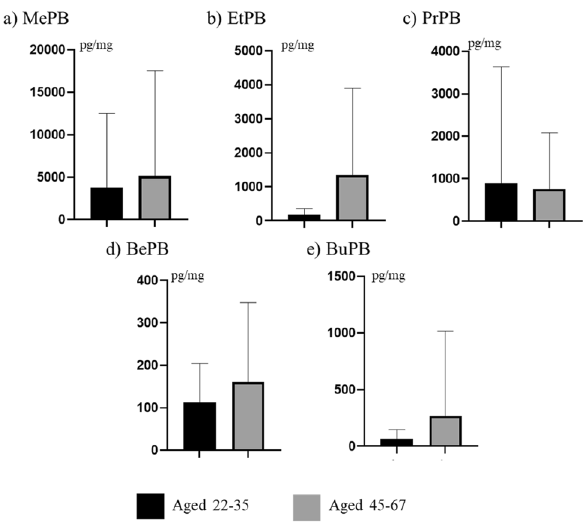
Figure 3. Mean concentration levels (± SD) of parabens in persons at the age of 22–35 and